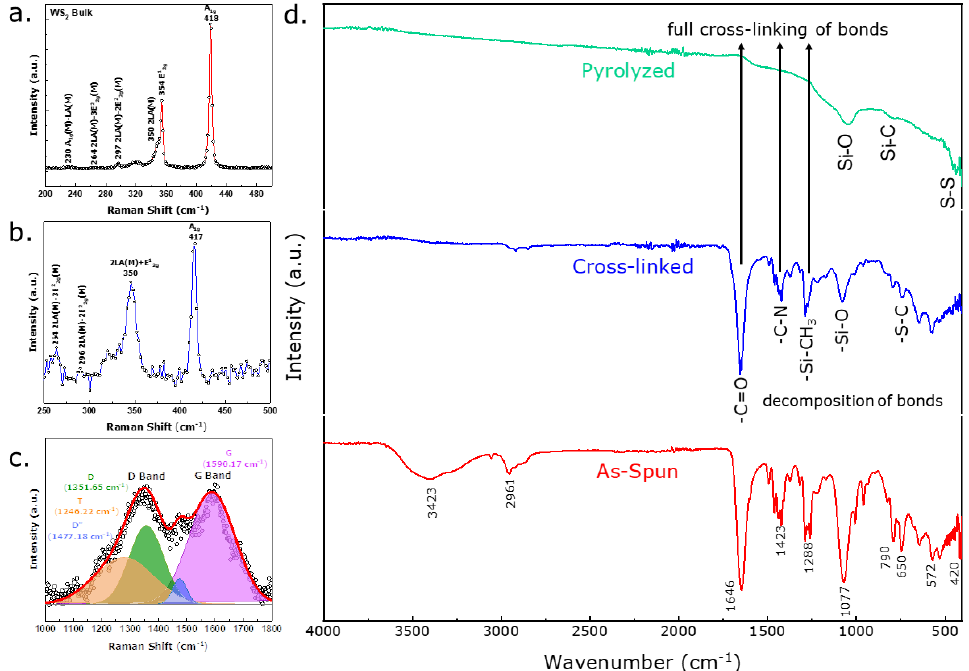
Figure 2. Raman Spectra of ( a ) Bulk WS 2 powder showing the typical position of the peaks obtained from the neat material; ( b ) WS 2 /SiOC fibermat in the lower wavenumber region confirming the presence of the WS 2 nanosheet material within the fibermat showing the same peaks as the bulk material with subtle differences; ( c ) WS 2 /SiOC fibermat in the higher wavenumber region confirming the free carbon species (integrated spectra using a gaussian function); ( d ) FTIR spectra of As-spun, cross-linked, and pyrolyzed fibermats. The spectra from top to bottom illustrate data obtained from individual pyrolyzed, cross-linked and as-spun fibermats.